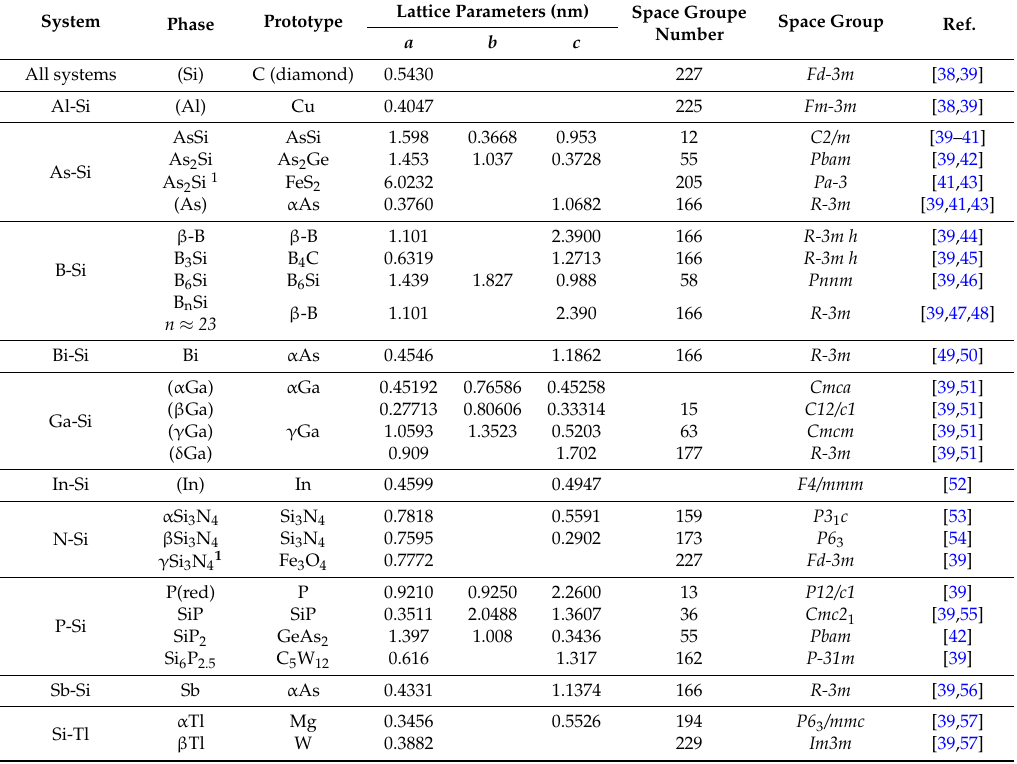
Table 2. Crystallographic data of the solid phases in the binary systems covered in the current